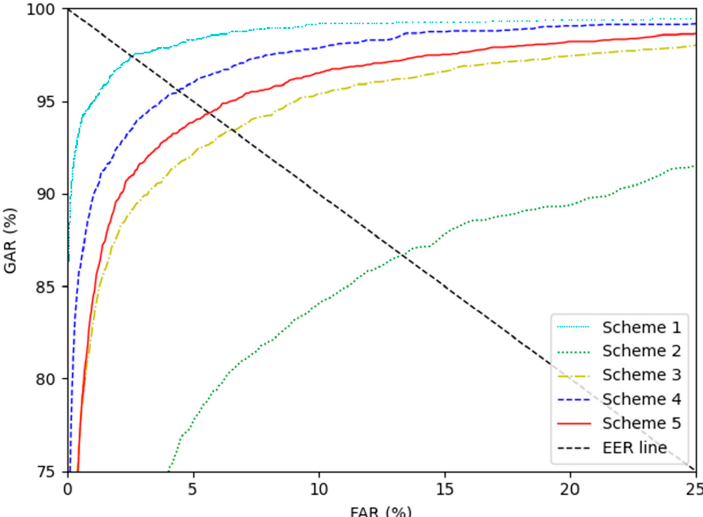
Figure 15. ROC curves of finger-vein recognition for schemes 1–5 with SDU-DB (random motion blur and optical blur with intensity 11 × 11 (Gaussian filter size) and 11 (Gaussian filter standard deviation)).